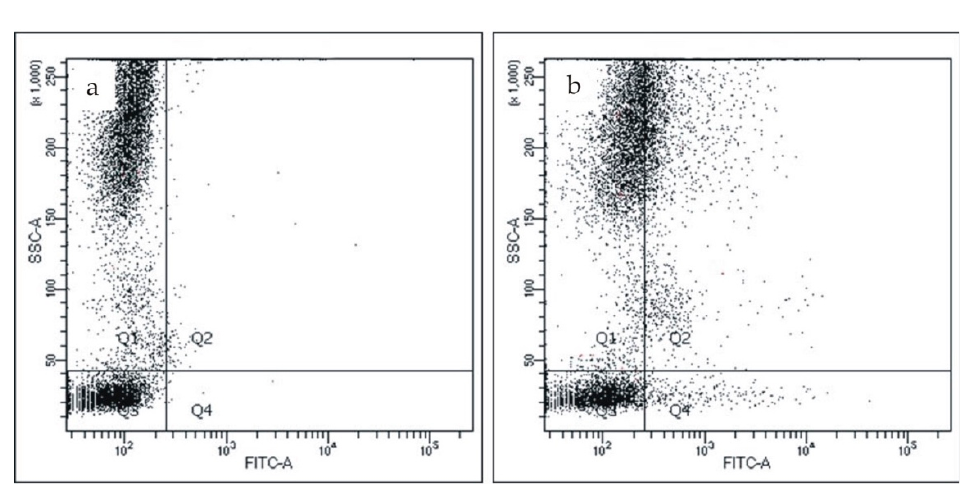
Table 1. CRP-positive cells.